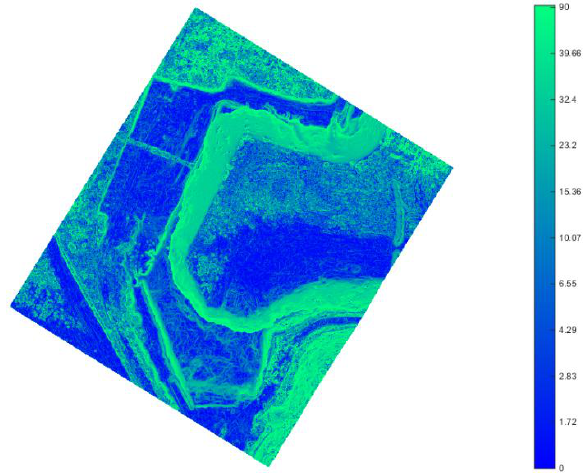
Figure 7. Slope map for Scenario 1